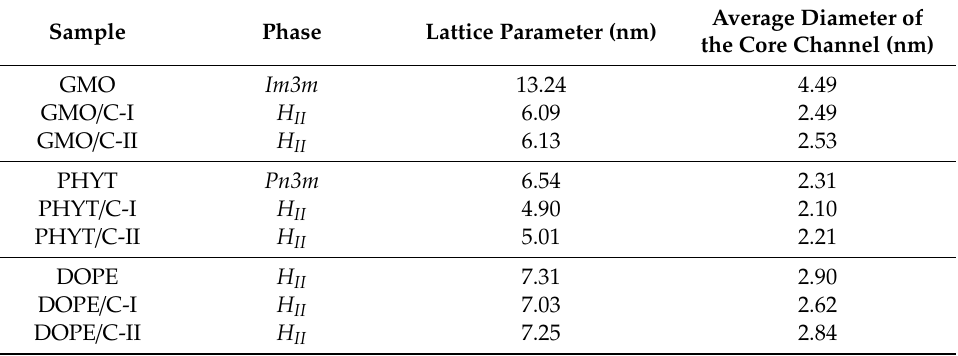
Table 1. Phase structure, lattice parameters and diameter of aqueous channels of GMO, PHYT and DOPE empty and